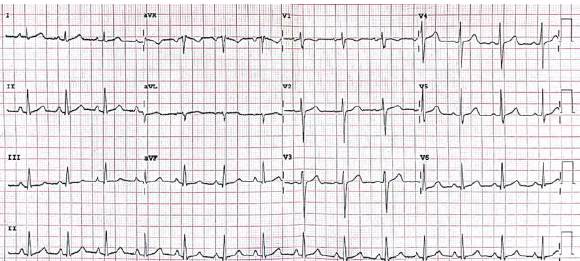
Figure 1. A “normal” 12-lead